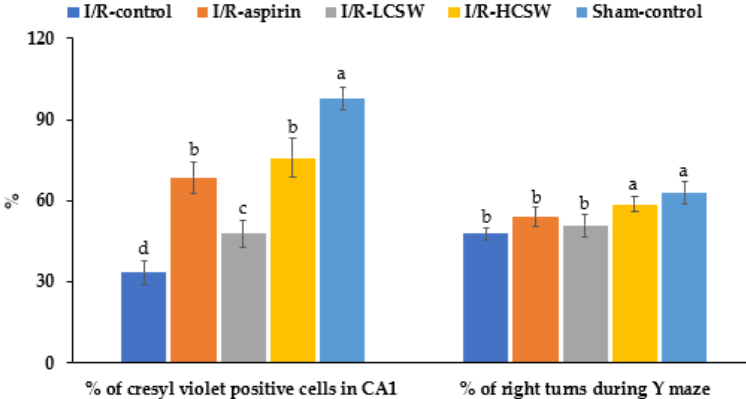
Figure 2. Brain cell death and memory loss after ischemic stroke. Gerbils that underwent the transient forebrain ischemia by carotid artery occlusion for 8 min and reperfusion were randomly divided into four groups, as follows: (1) 0.2% cellulose (I/R-control), (2) 0.02% aspirin (I/R-aspirin), (3) 0.05%